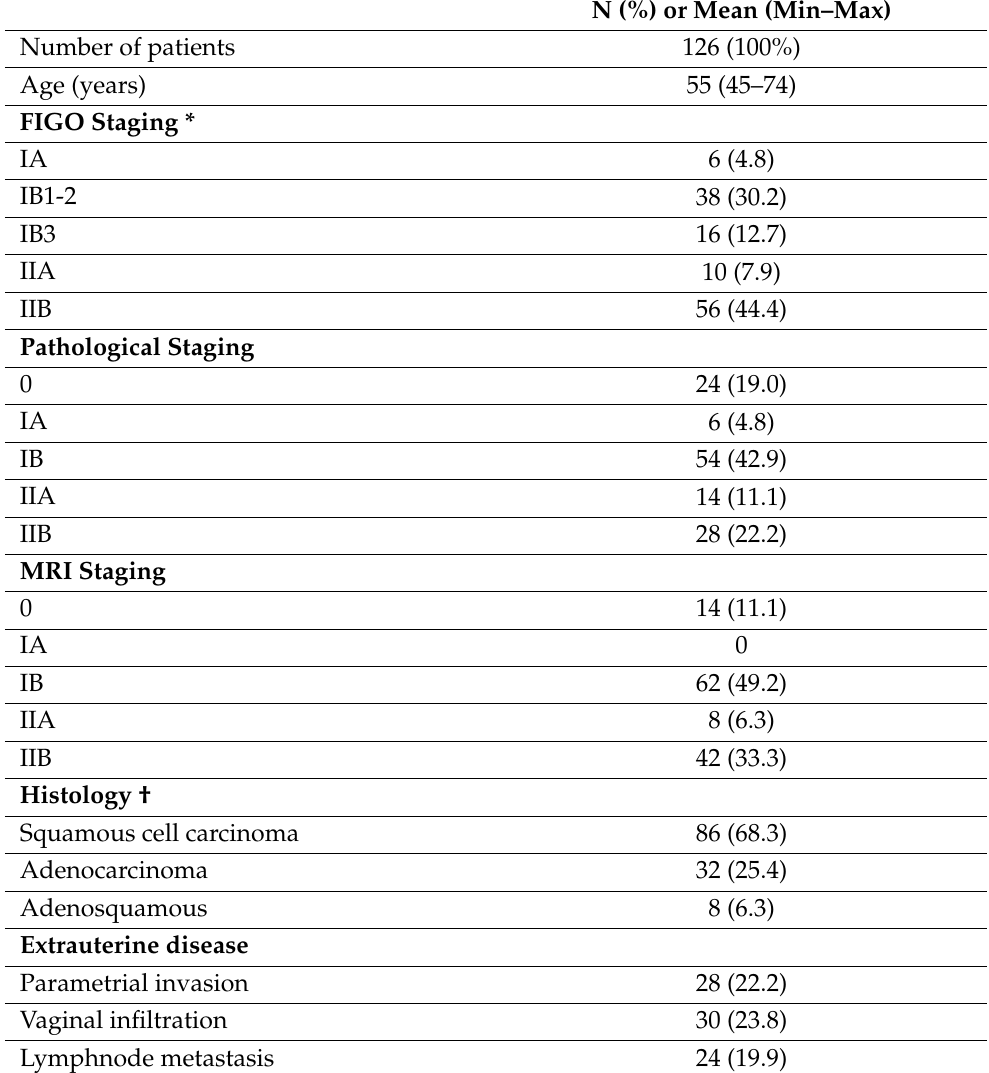
Table 1. Characteristics of the patients included in the